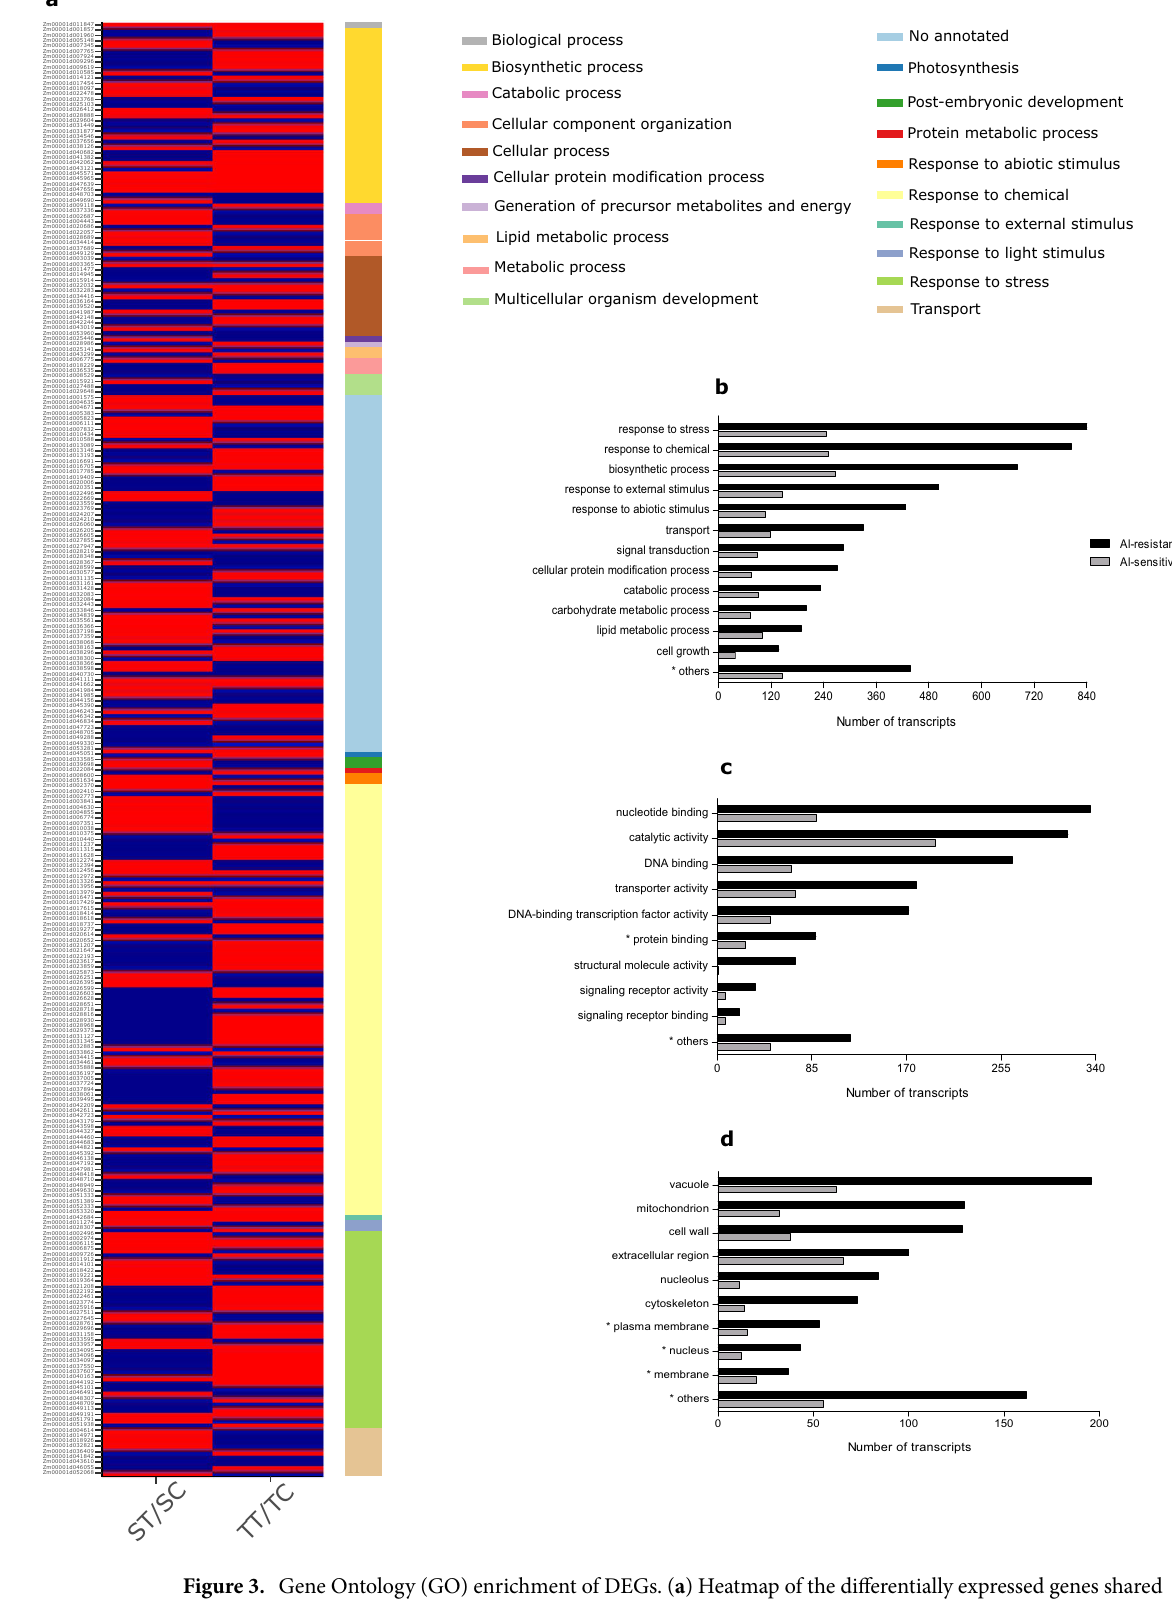
Figure 3. Gene Ontology (GO) enrichment of DEGs. ( a ) Heatmap of the differentially expressed genes shared in both inbred lines—ST/SC: contrast between Al-sensitive line under treatment/control conditions; TT/TC: contrast between Al-resistant line under treatment/control conditions. ( b ) Biological process. ( c ) Molecular function. ( d ) Cellular component. *The numbers of genes were divided by 10. Heatmap was generated in R version 3.6.2 (https:// www.r- proje ct.